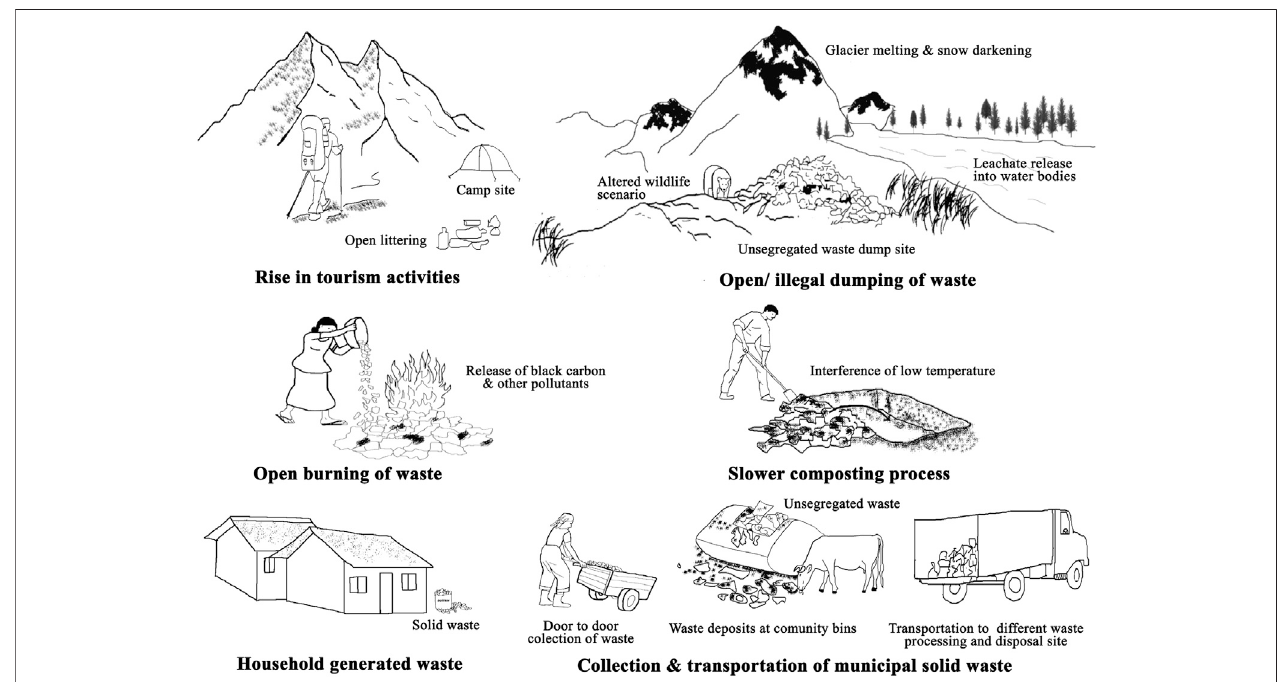
FIGURE 2 | A schematic representation depicting the major challenges of SWM in the IHR. The primary challenges summarized in the image are open littering due totheriseintourismactivities;irregulartopographicalcon fi guration;open/illegaldumpingofwaste;slowercompostingprocess;improperwastecollectionanddisposal; and open burning of waste leading to release of black carbon, and other pollutants that may cause snow darkening and glacier melt.